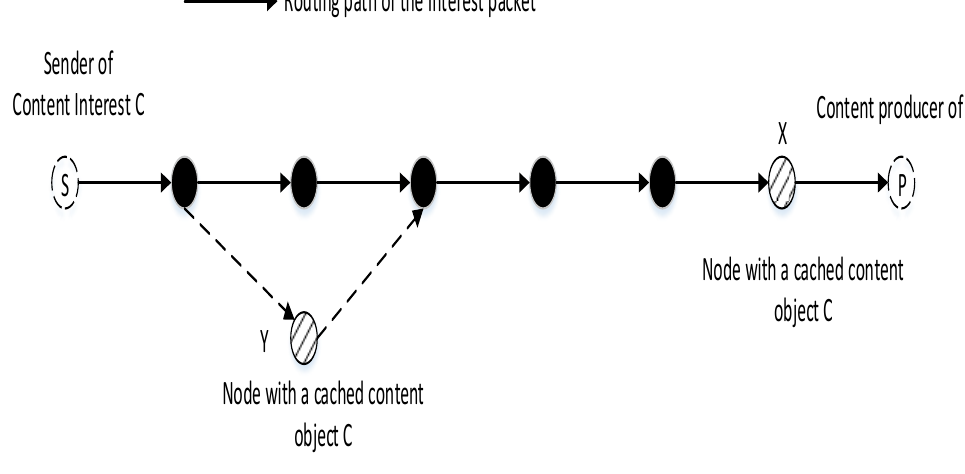
Figure 1. Problem